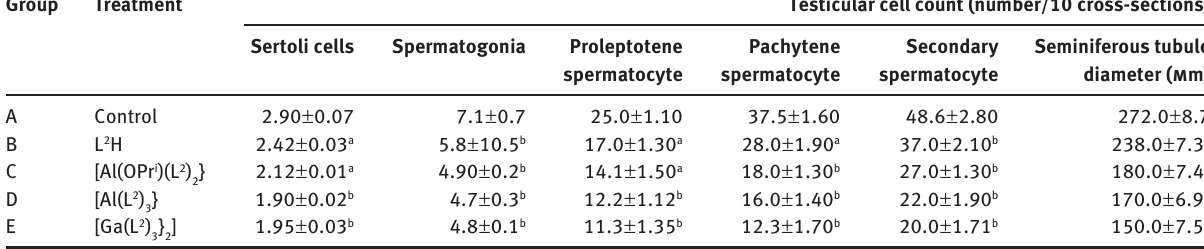
Table 10 Effect of the ligand (L 2 H) and its corresponding complexes on testicular cell population and seminiferous tubule diameter of experimental rats (mean ± SEM of six animals). Group Treatment Testicular cell count (number/10